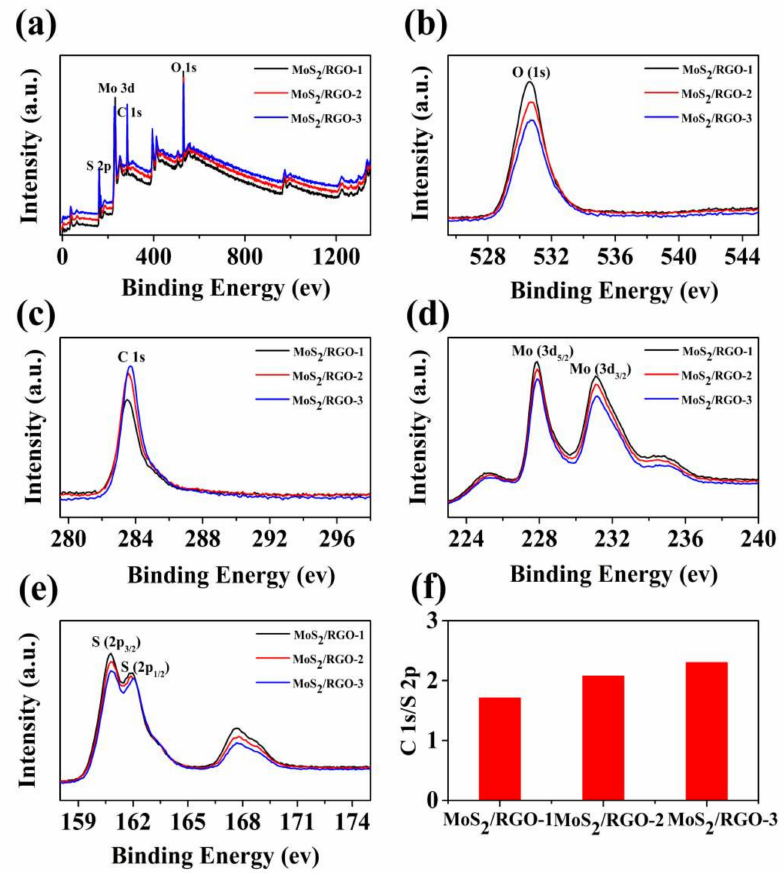
Figure 4. XPS spectra of MoS 2 /RGO composites ( a ) high-resolution spectra, ( b ) O1s ( c ) C1s, ( d ) Mo3d, ( e ) S2p, and ( f ) ratio of the intensity of C1s to